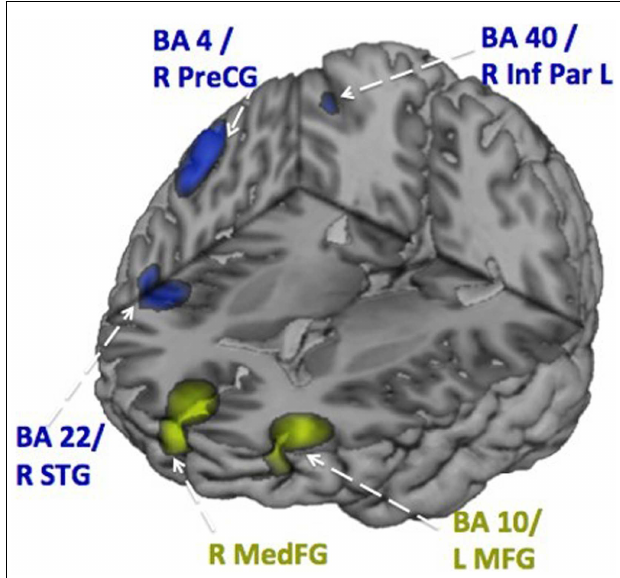
FIGURE 5 |Activation patterns during inhibition. Distributed activation patterns at 350–400ms in the adolescents with ASD (in green) and the age-matched typically developing adolescents (in blue) showing that control adolescents used a wider network, that also involved temporal lobe activation, than adolescents with ASD.These data were analyzed with vector beamforming as described in Figure 2